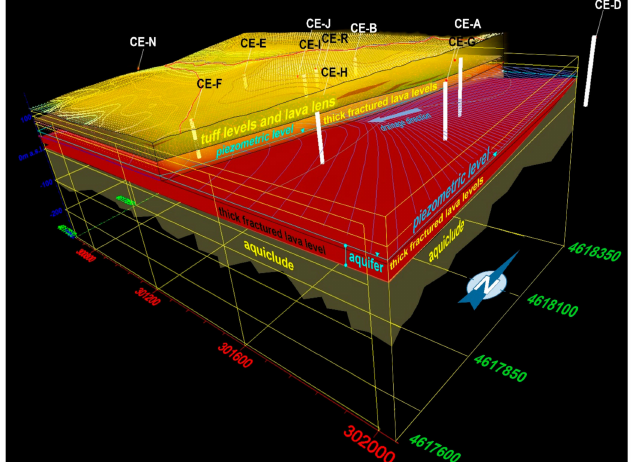
Figure 3. Detailed 3D sketch of the area investigated: groundwater (blue line), aquiclude (green), lavas (red) and tu ff formations (yellow). Each white vertical pin corresponds to a piezometer (CE-A, CE-B, CE-C, CE-D, CE-F, CE-G, CE-H, and CE-I). The geological cross-section is oriented from North-East to South-West (NE–SW). The surface red line corresponds to the contour of the waste treatment